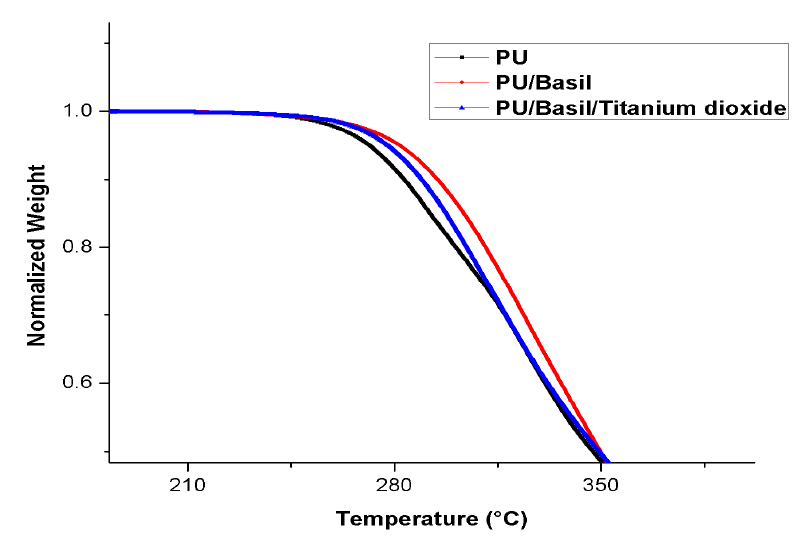
Figure 8. TGA of PU, PU/BASIL and PU/BASIL/TiO 2.